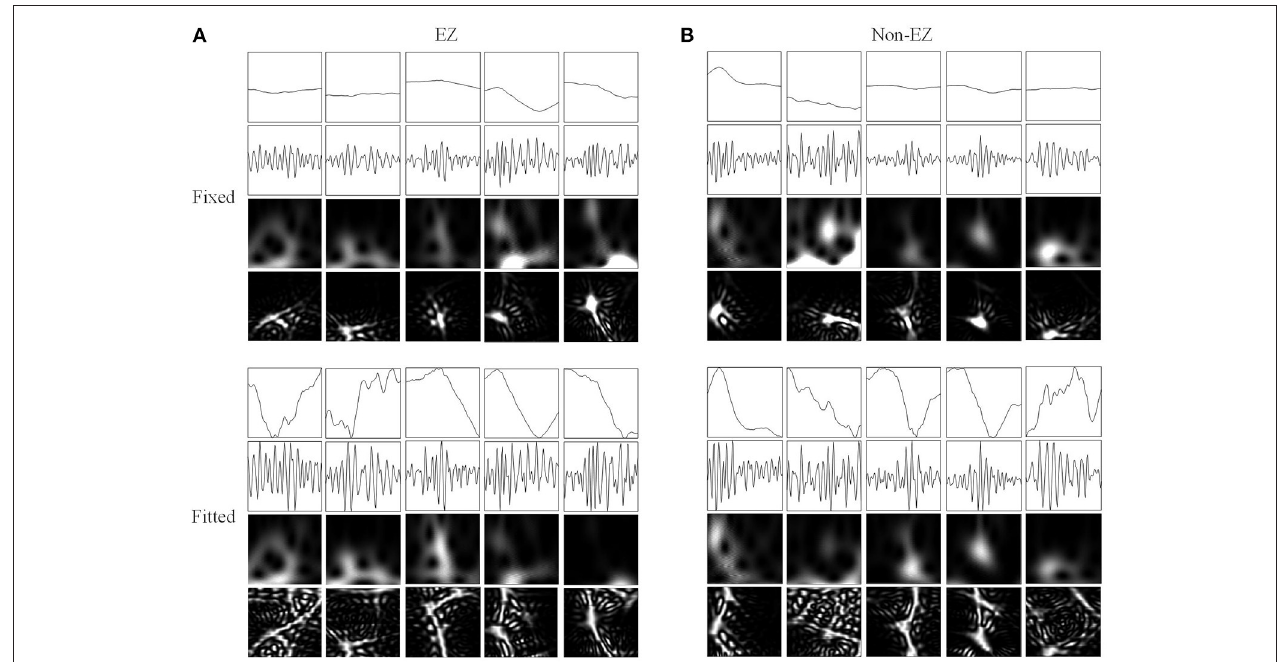
FIGURE 6 | Network inputs in the form of two-dimensional pictures of FRs. (A) Two-dimensional pictures (96 × 96 × 1 pixel) of five FRs in different channels of EZs. Upper and lower four panels are fixed and fitted scales. The four panels are original waveforms, filtered (200–500Hz) waveforms, wavelet spectrum images, and SPWVD spectrum images. (B) Two-dimensional pictures (96 × 96 × 1 pixel) of ripples in different channels of non-EZs. Upper and lower four panels are fixed and fitted scales. The four panels are original waveforms, filtered (200–500Hz) waveforms, wavelet spectrum images, and SPWVD spectrum